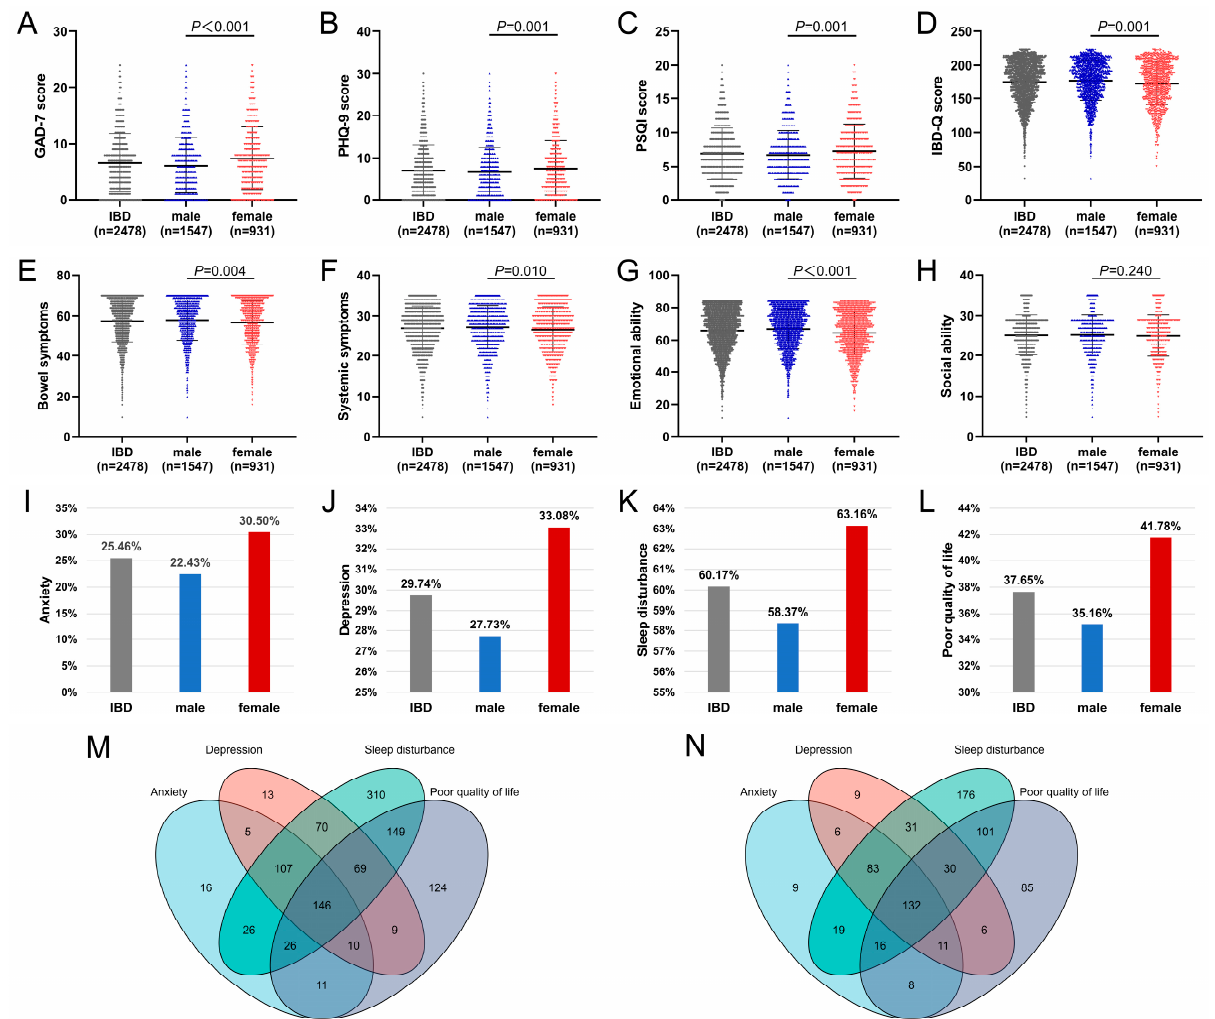
Figure 1. GAD-7 score ( A ), PHQ-9 score ( B ), PSQI score ( C ), IBD-Q score ( D ), anxiety rate ( I ), depression rate ( J ), sleep disturbance rate ( K ), and poor quality of life rate ( L ) of IBD patients. Venn diagram (( M ): males; ( N ): females). IBD-Q score including 4 dimensions of bowel symptoms ( E ), systemic symptoms ( F ), emotional ability ( G ), and social ability ( H ). (IBD: inflammatory bowel disease; UC: ulcerative colitis; CD: Crohn’s disease).